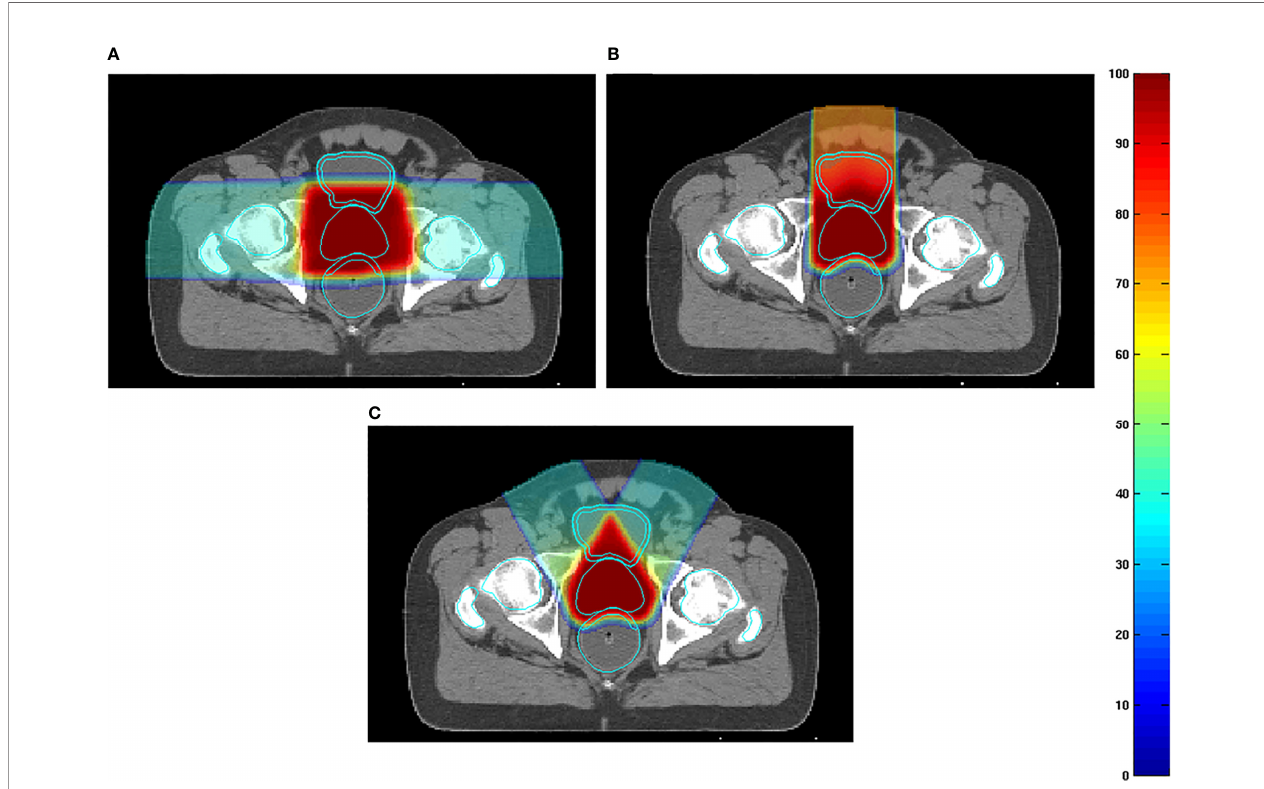
FIGURE 7 | (A) Examples of dose distributions for two parallel-opposed lateral fi elds, (B) one straight anterior fi eld, and (C) two anterior-oblique fi elds in an axial plane. The prostate, rectum, anterior rectal wall, bladder, bladder wall, and femoral heads are outlined by cyan lines (51) (Source: Elsevier. Used with